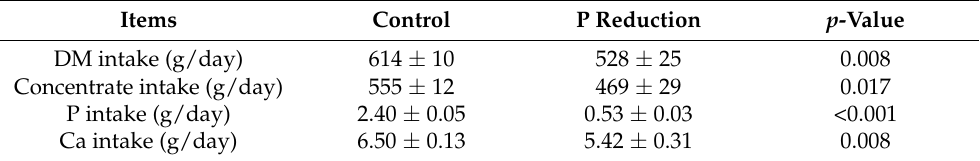
Table 1. Mean daily intake of dry matter (DM), concentrate, phosphorus (P) and calcium (Ca) of young goats fed a low P diet. (Mean values with their standard errors; n = 7 animals).